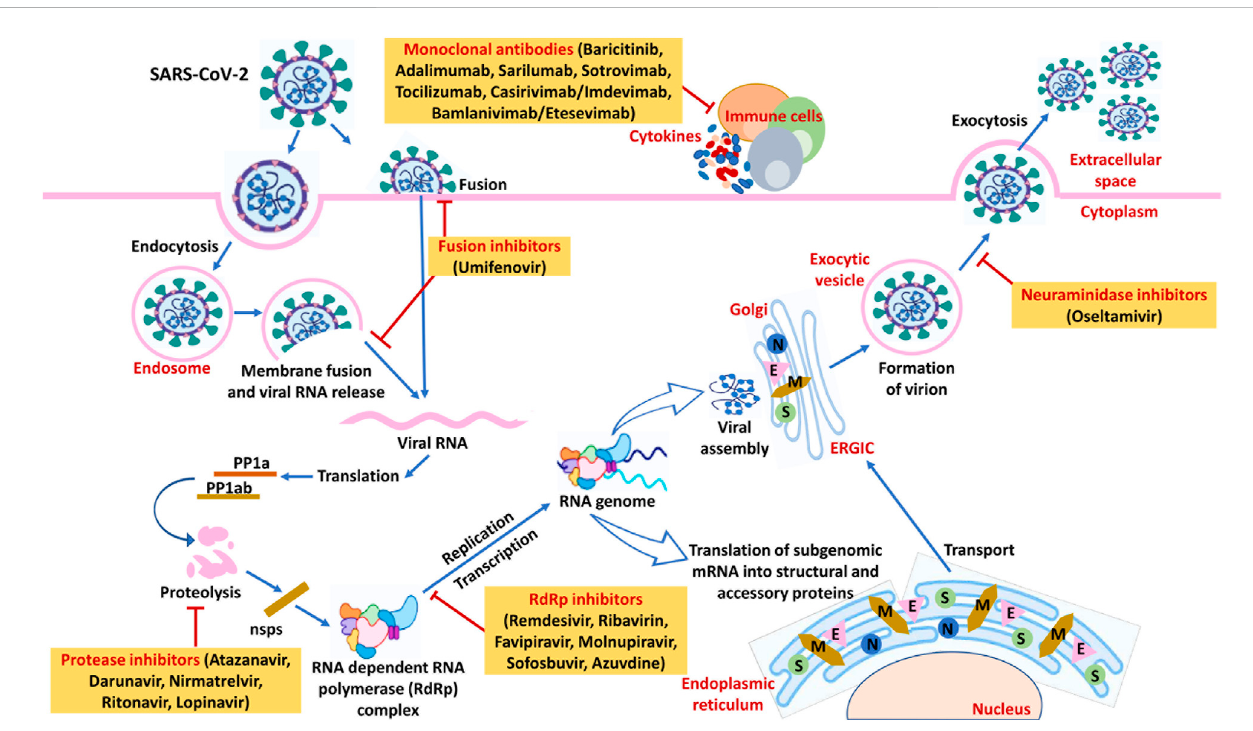
An overview of SARS-CoV-2 ’ s life cycle along with the potential targets of anti-viral drugs and monoclonal antibodies in COVID-19. On host cells, the spike protein (S) of SARS-CoV-2 interacts with the cellular receptor ACE2 followed by viral entry into the host cell. It happens either by fusion of the virus with plasma membrane due to activation by serine protease or activation by endocytic machinery of the host resulting in viral and cellular membranes fusion. The viral genome is unveiled in the cytoplasm and translated to viral replicase polyproteins (PP1a and PP1ab) followed by subsequent cleavage to form nonstructural proteins (nsps) via proteinases of the virus. Some of the nsps consequently form the replicase-transcriptase complex as RNA-dependent RNA polymerase (RdRp). Through intermittent transcription, the polymerase generates subgenomic mRNA series that is ultimately translated into functional viral proteins. In the cytoplasm, viral nucleocapsids are formed with genomic RNA and N proteins accompanied by budding in the ERGIC lumen. The virus is then released from the host ’ s infected cell to the extracellular space via exocytosis. Medications with signi fi cant anti-SARS-CoV-2 action including anti-viral drugs andmonoclonalantibodiesactingonthedifferentphasesofthevirus ’ slifecyclehavebeenalsoillustratedinthe fi gure.Abbreviation-S:Structuralproteins,E: Envelope, M: Membrane, N: Nucleocapsid, ACE2: Angiotensin-converting enzyme 2, ERGIC: Endoplasmic Reticulum- Golgi intermediate